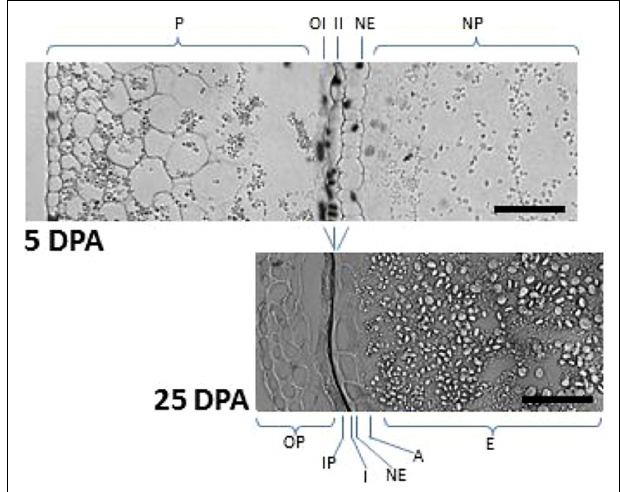
FIGURE 3 |TUNEL assay showing maternal tissues undergoing PCD at early and late stages of wheat seed development. In seeds at 5 DPA, nuclei from the nucellus and the integuments showedTUNEL-positive signal. Note the reduction of pericarp width and the formation of seed cuticles as a consequence of PCD (compare 5 DPA vs 25 DPA). Starch granules of different sizes are also observed in the starchy endosperm.